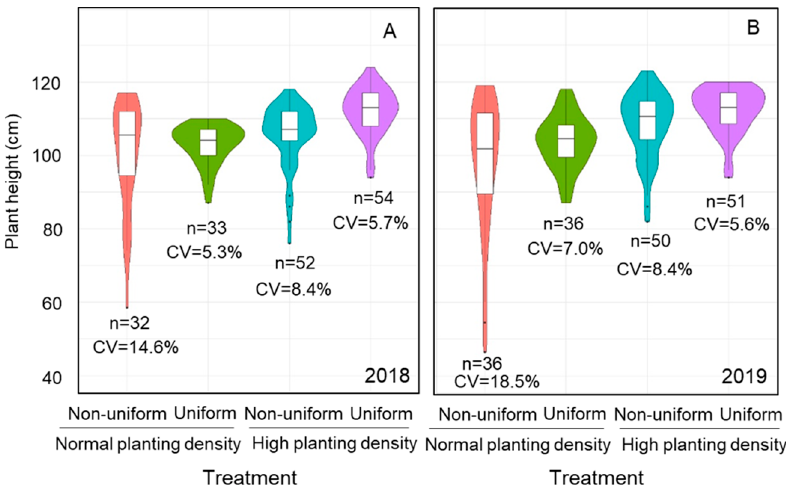
Figure 4. Effect of plant distribution on soybean plant height during the 2018 ( A ) and 2019 ( B ) growing seasons under different planting densities. CV, coefficient of variation.